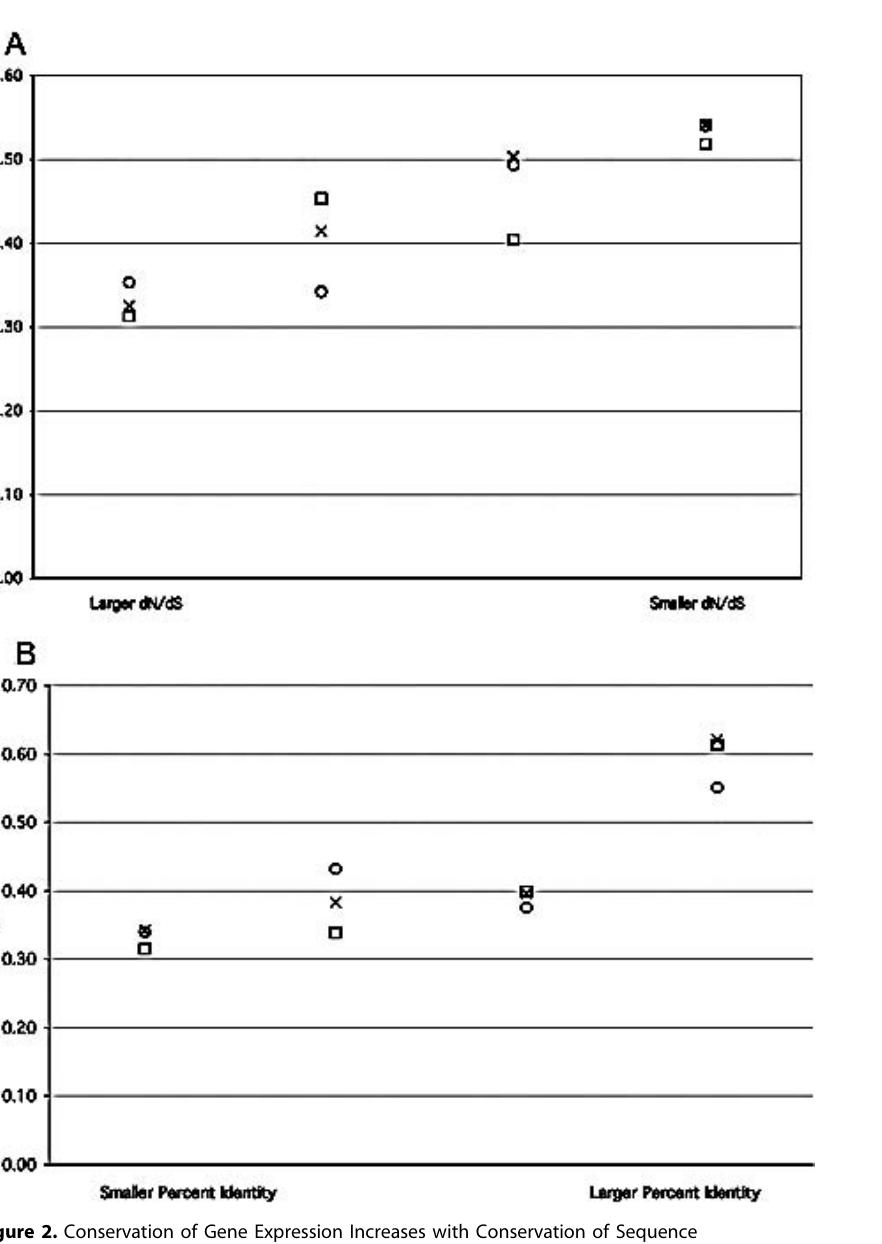
Figure 2. Conservation of Gene Expression Increases with Conservation of Sequence (A) Othologous human and mouse genes were ranked by their dN/dS ratios, as given in the ENSEMBL database, from least conserved at the DNA sequence level (larger dN/dS), to most conserved. For each of the three pair-wise regional comparisons, the correlation coefficient between human and mouse log ratios was determined and plotted for each quartile of genes. (B) Orthologous genes were ranked by their percent nucleotide identity, as given in the ENSEMBL database, and quartile correlation coefficients were determined and plotted for each quartile of genes. X, caudate or striatum-to-cerebellum; Circle, cortex-to-cerebellum; Square, cortex-to-caudate or